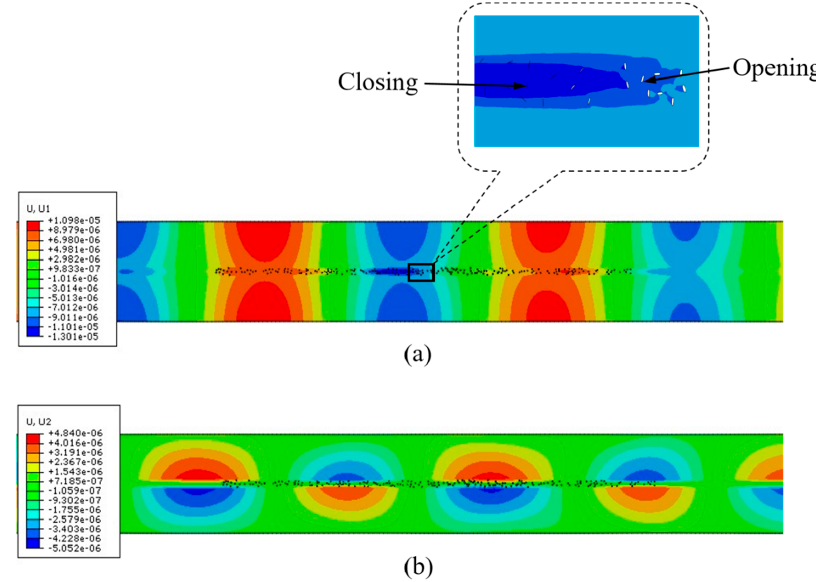
Figure 6. The Lamb waves propagating in the tri-layer adhesive structure. ( a ) The displacement contour in the x -direction and the 5000-times magnified deformed shapes; ( b ) the displacement contour in the z - direction.